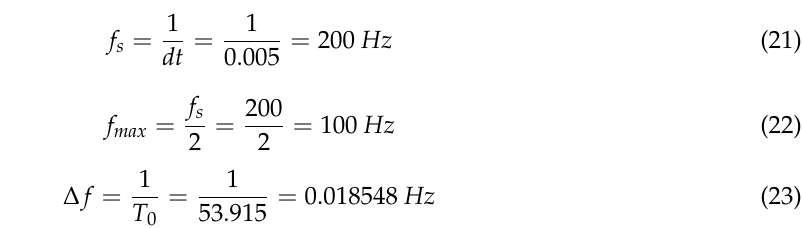
Method 1: ( a ) discrete Fourier Transform of the applied load; ( b ) transfer function; ( c ) acceleration;